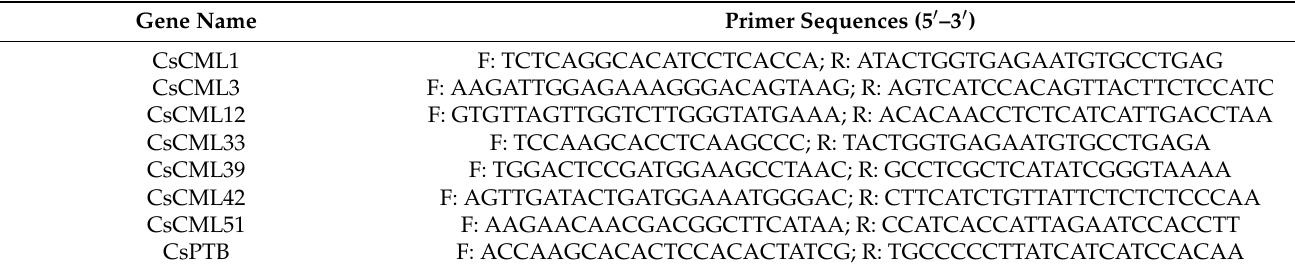
Table 1. Primers for